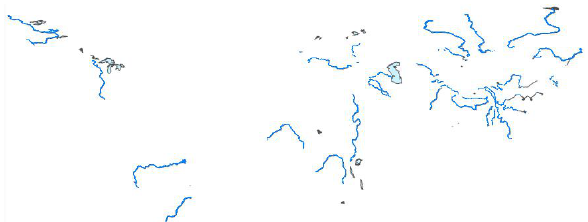
Figure. 11 Before Water System Generalization